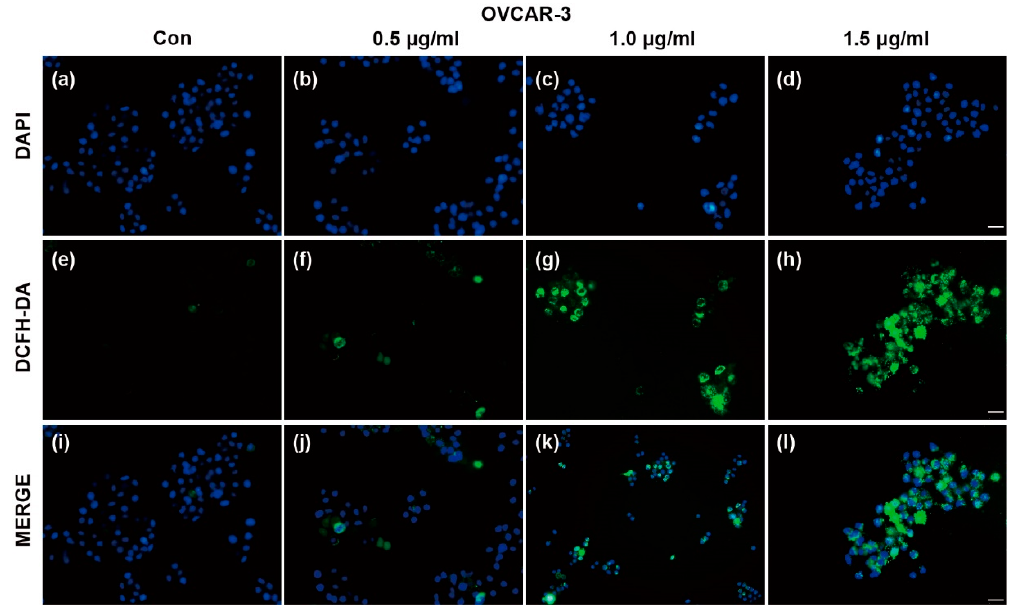
Figure 6. Effects of TFS on reactive oxygen species (ROS) generation in OVCAR-3 cells. ROS generation in OVCAR-3 cells was evaluated by DAPI and DCFH-DA double staining. Representative images are shown. After treatment with TFS (0, 0.5, 1.0 and 1.5 μ g/mL) for 24 h, cells were stained with DCFH-DA and DAPI and visualized by fluorescence microscopy (magnification 20×), scale bar = 50 μ m. The top line of images ( a – d ) shows cells stained with DAPI. The middle line of images ( e – h ) shows cells which generated ROS as represented by staining with DCFH-DA. The bottom line of images ( i – l ) shows merged fluorescence images of cells stained by DAPI and DCFH-DA.